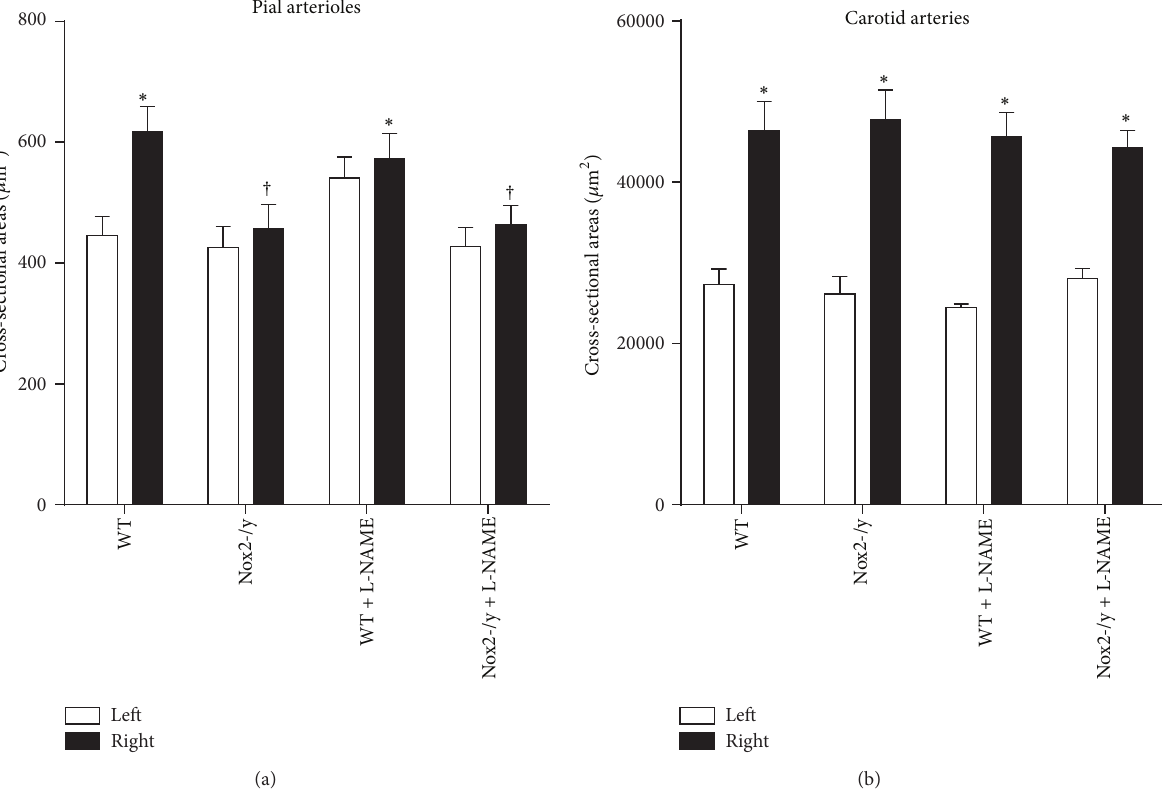
Figure 4: Graph showing cross-sectional areas of maximally dilated cerebral arterioles (a) and carotid arteries ( 𝑛 = 8 ) (b). ∗ 𝑃 < 0.05 versus left-sided WT group; † 𝑃 < 0.05 versus right-sided WT